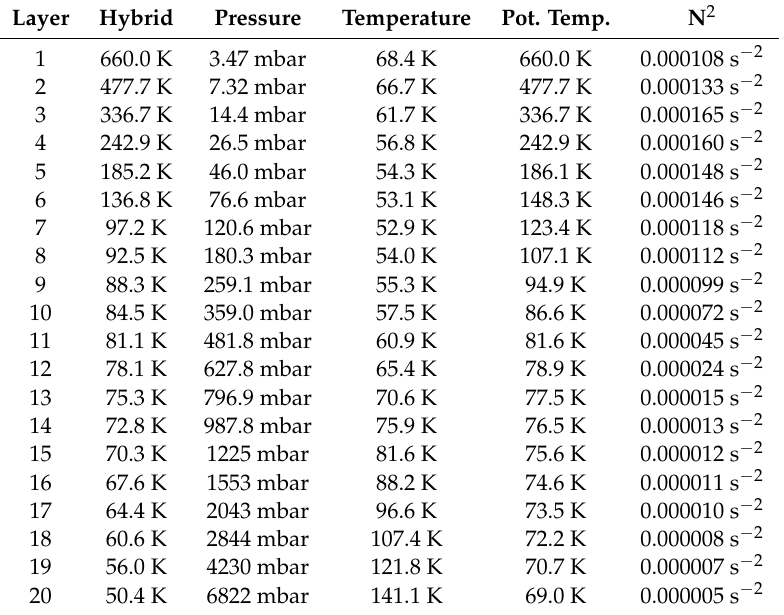
Table 1. Initial vertical layer